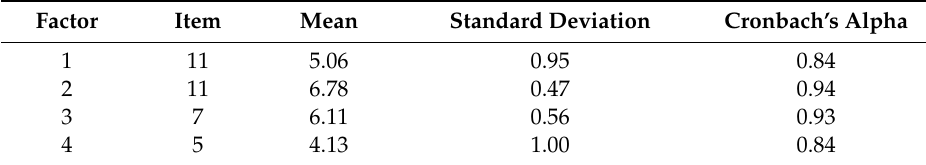
Table 2. Cronbach’s alpha values ( n = 2343).